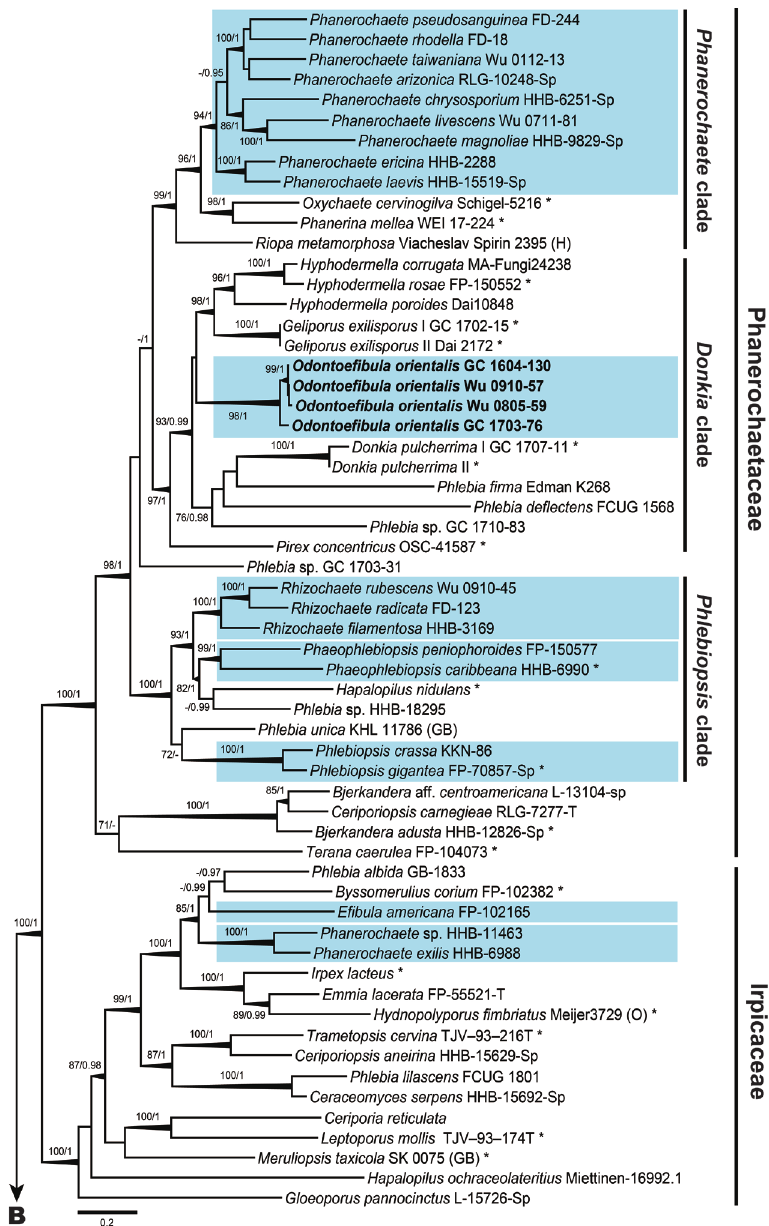
Figure 1. Phylogenetic tree inferred from Maximum Likelihood analysis of the combined ITS, nuc 28S, rpb1 , rpb2 and tef1 sequences of taxa in Polyporales. Nodes are labelled with Maximum Likelihood boot- strap proportional values (BS) ≥ 70% and Bayesian Posterior Probabilities (PP) ≥ 0.9. Thickened branches obtained supports by both BS ≥ 80% and PP ≥ 0.95. The taxa studied in this study are shown in bold. The pale blue boxes indicate lineages of phanerochaetoid fungi within the phlebioid clade. Asterisks (*) represent for strains of generic type species. Scale bars = substitutions per